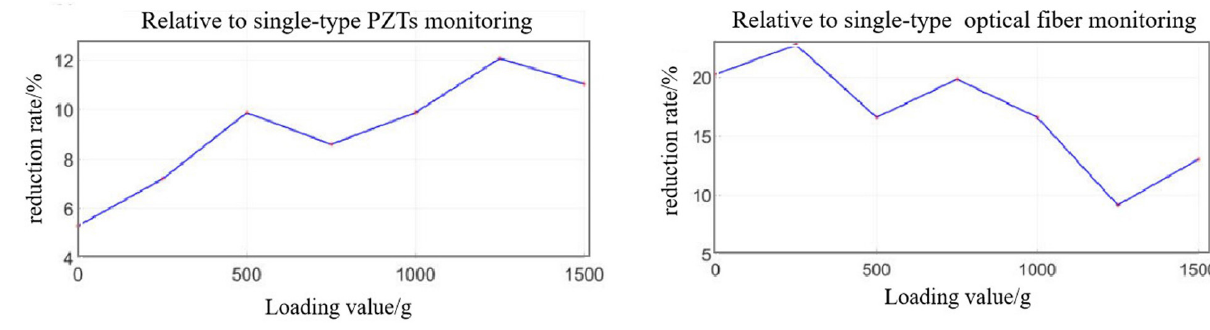
is attributed to the strain change in Y direction mainly caused by the bending